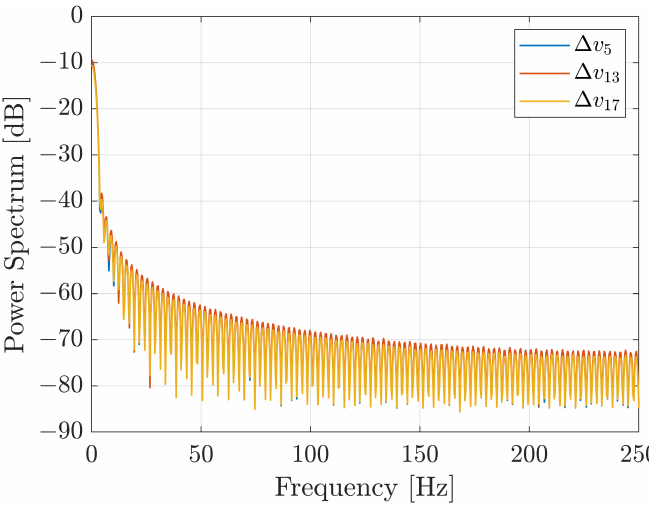
Figure 13. Power spectrum of taxels 5, 13 and